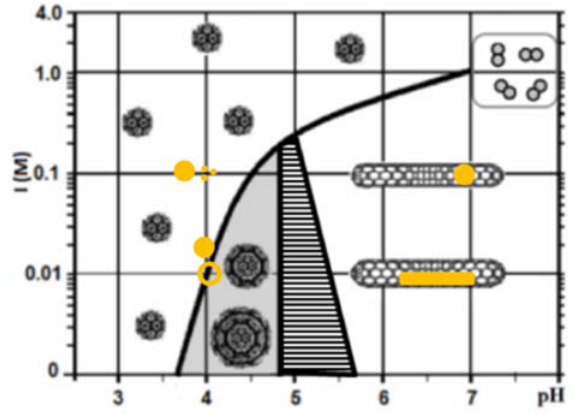
Figure 1. Phase diagram of the cowpea chlorotic mottle virus (CCMV) capsid protein (CP) self-assembly as a function of pH and ionic strength. The golden color structures represent each of the di ff erent gold nanoparticles; gold nanospheres (Ø ~ 18 and ~5 nm in diameter), gold nanoshells (Ø ~ 25 nm) and gold nanorods (aspect ratio ~4.1 nm). Each structure is placed under the conditions in which the virus-like particle (VLP) assemblies were formed. The figure was adapted from [8].